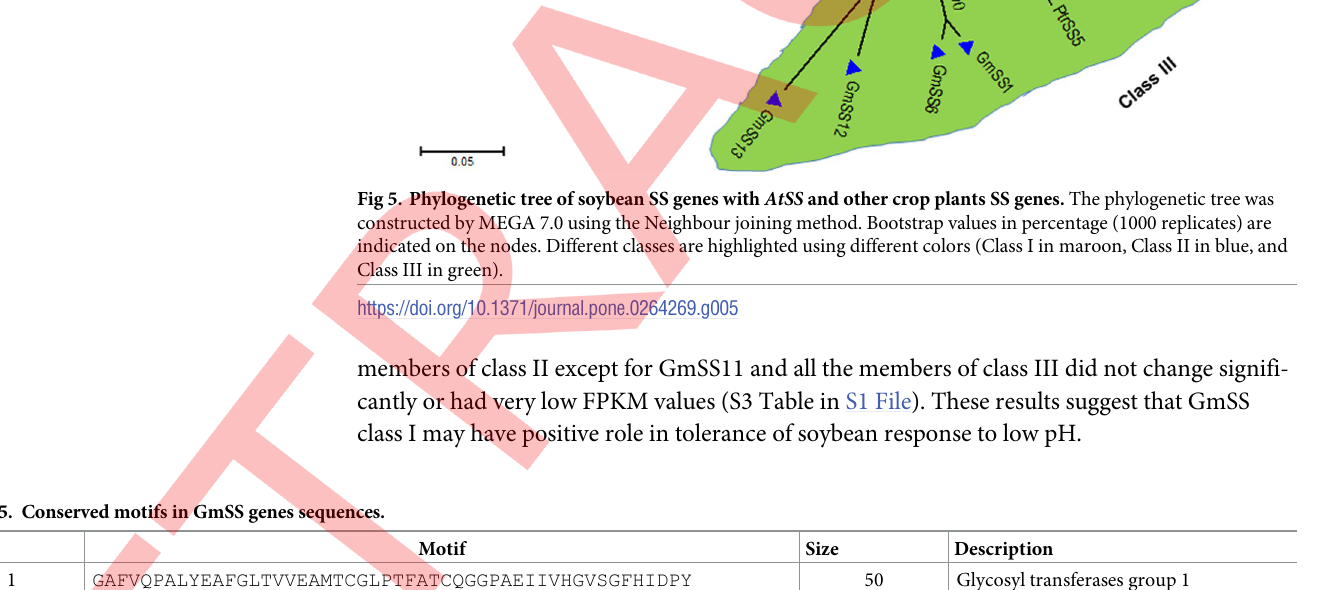
Table 5. Conserved motifs in GmSS genes